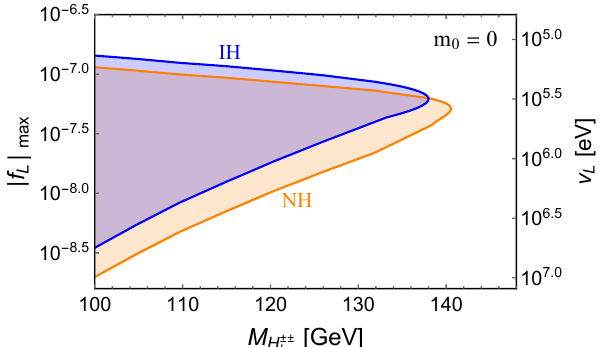
Figure 8 . Limits on M in the type-II seesaw and its largest Yukawa coupling j f L j max from H (cid:6)(cid:6) L searches of doubly-charged HSCPs by the CMS group [102]. The orange and blue regions are excluded respectively for the NH and IH cases with the lightest neutrino mass m 0 = 0. The corresponding limits on the VEV v L are also shown in this